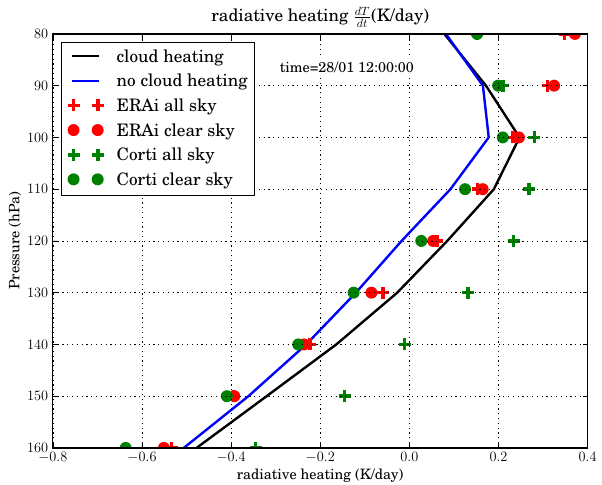
Figure 9. Profiles of radiative heating rates on 28 January 2009, 12:00UTC, in the WRF domain, for the simulations with (black) and without (blue) cloud heating included. For comparison, the 3h averaged clear-sky and all-sky radiative heating rates in the ERA- Interim reanalysis are shown in red, together with the estimates from Corti et al. (2006) for clear-sky and all regions in